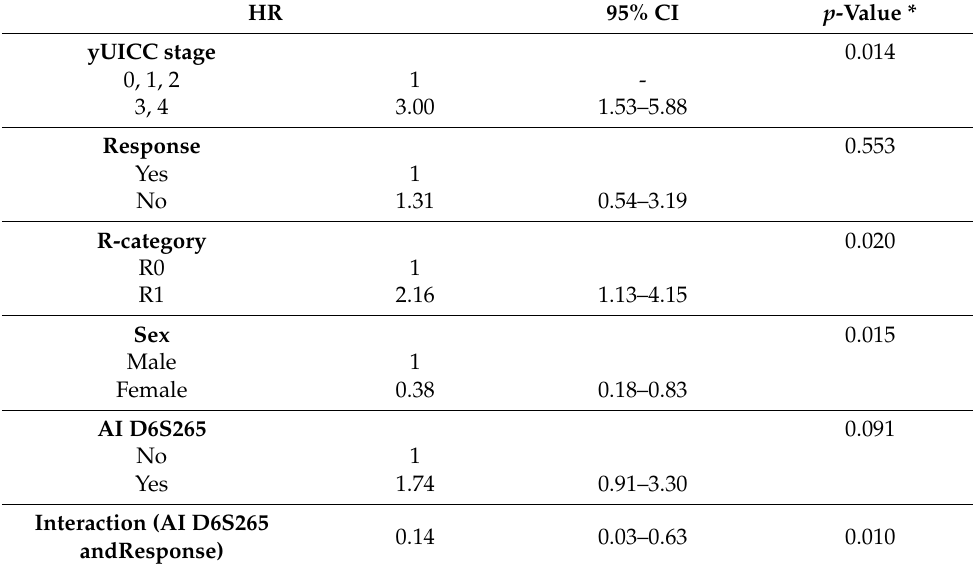
Table 5. Multivariable Cox regression